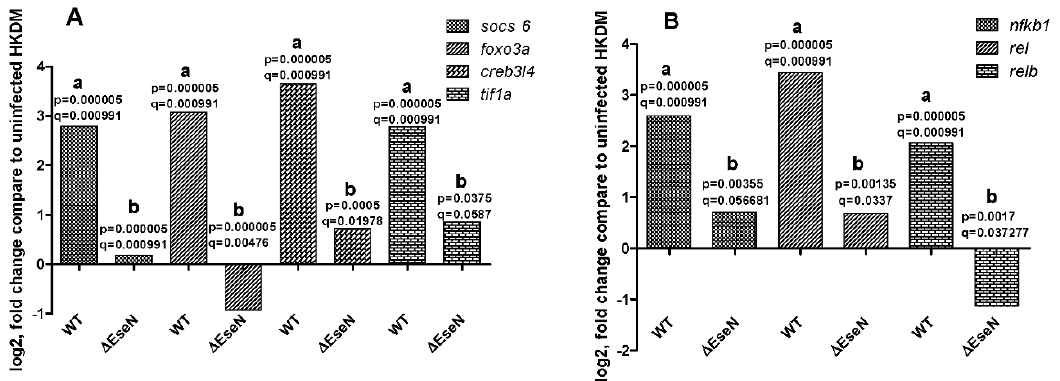
Figure 4. Transcription factor expression. RNAseq data from three independent replicates. ( A ) Not NFκ - β transcription factors. ( B ) Subunits of NFκ - β. Each column represents the mean fold change compared to uninfected HKDM from three independent biological replicates. (WT) HKDM infected with WT, (∆EseN) HKDM infected with ∆EseN. The p and q values indicate significance between a: HKDM infected with WT against not infected HKDM, b: HKDM infected with WT, and HKDM infected with ∆EseN mutant.